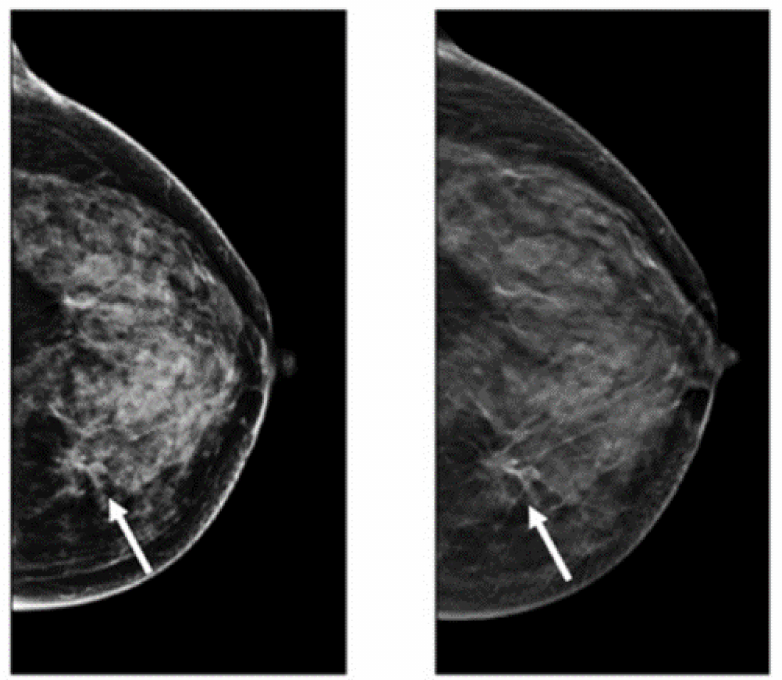
Figure 2. Images of cancerous breast tissue by DBT imaging modality [61]. Reprinted/adapted with permission from [61]. 2021,